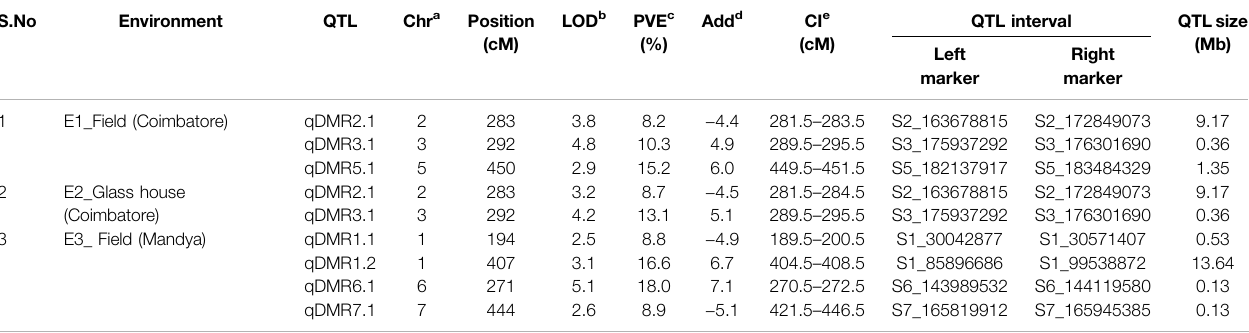
TABLE 3 | Details of QTL identi fi ed for SDM resistance in the recombinant inbred line (RIL) population derived from a cross of UMI79 × UMI936 (w) over the three